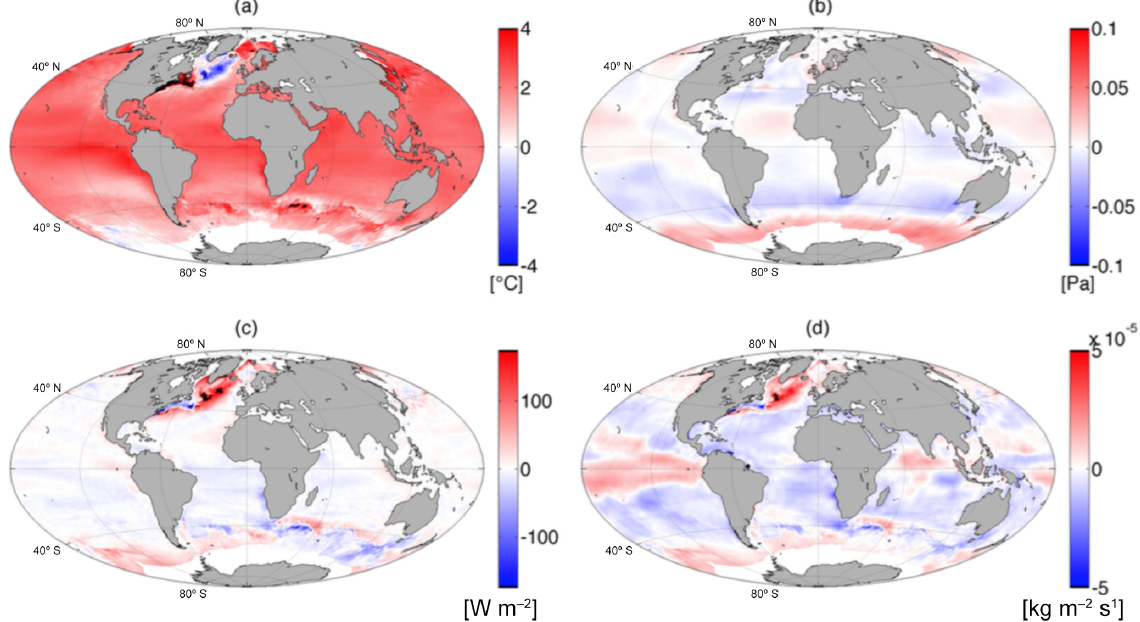
Figure 6. Change in (a) sea surface temperature ( ◦ C), (b) zonal wind stress (Pa), (c) surface heat flux (Wm − 2 ), and (d) surface freshwater flux (kgm − 2 s − 1 ) for the R 021 simulation; again the mean over the last 20 years (2081–2100) minus that over the first 20 years (2001–2020) is shown. (positive values mean a flux into the ocean).